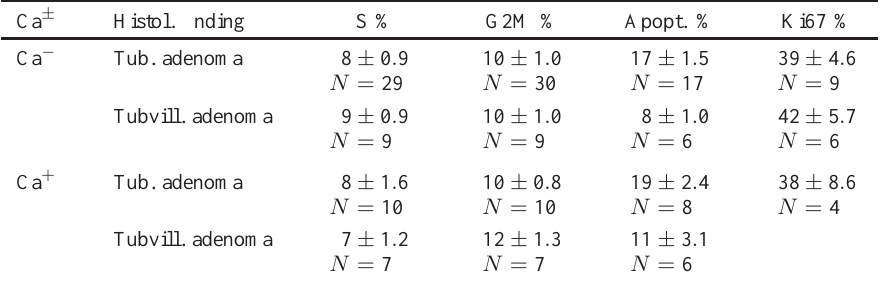
Table 2 Cell cycle distribution, subdiploid apoptotic fraction and Ki67 positive cells in DNA diploid